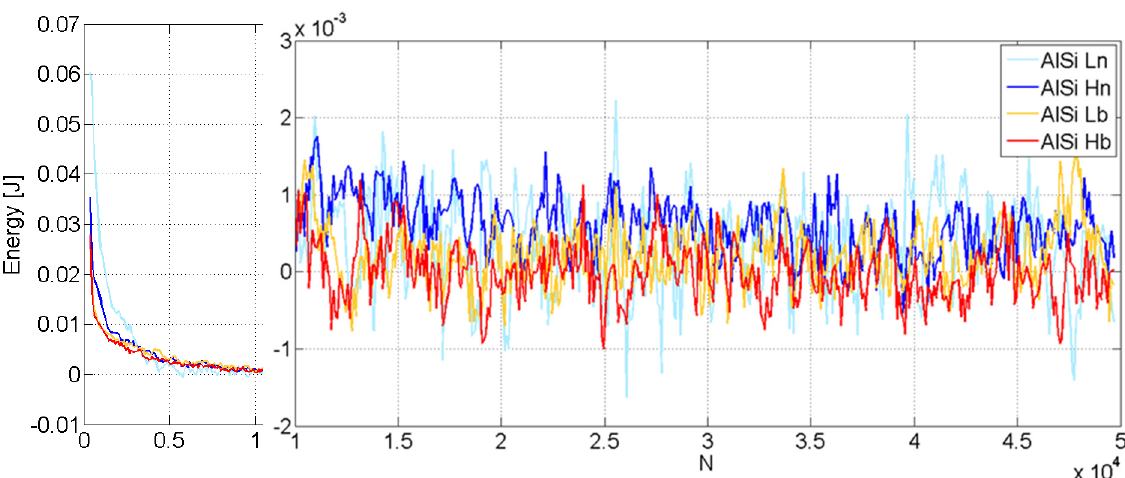
Figure 13. Mechanical work W absorbed(i) absorbed in each loading cycle vs. the total number N of cycles; different y-scales are used for N < 10 4 cycles and for N > 10 4